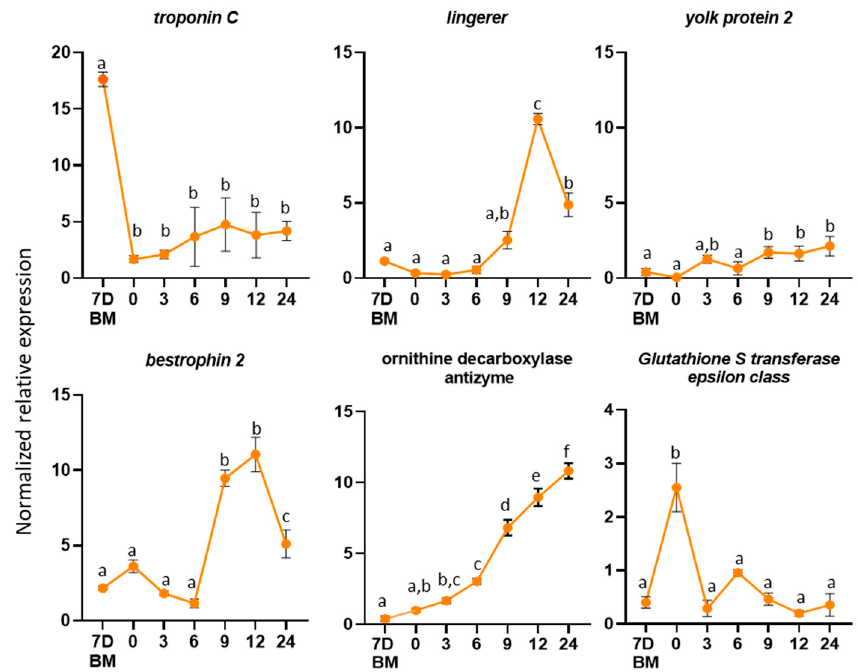
Figure 5. Expression profiles in female reproductive tissues. Expression profiles of the selected genes from the virgin flies and several timepoints after mating (0, 3, 6, 9, 12 and 24 h). The error bars show the standard error of the mean between three biological samples. Small different letters next to the SD bars indicate a significant difference among different samples ( p < 0.05, one-way ANOVA with Tukey’s test).